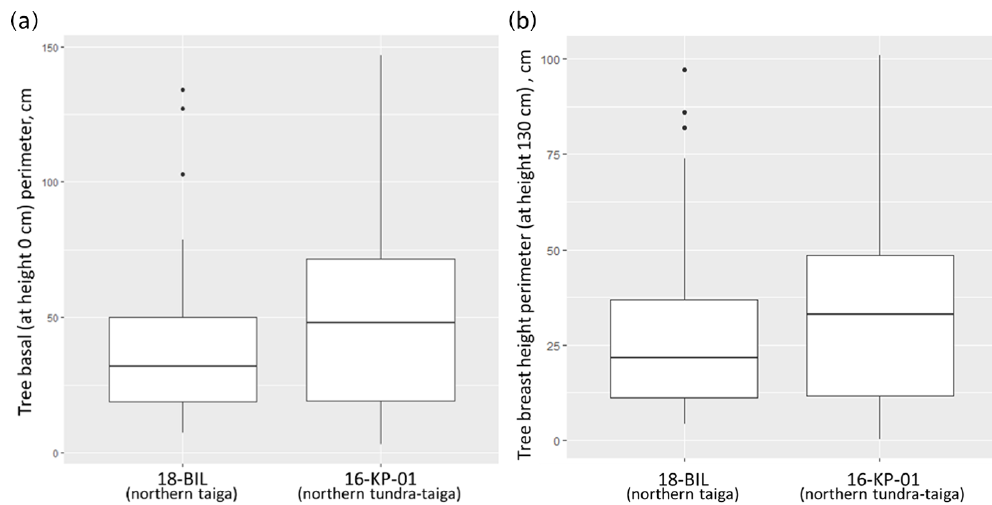
Figure A1. Distribution of basal (a) and breast height (b) diameter values of trees from two focus areas: northern taiga (18-BIL) and northern tundra–taiga (16-KP-01). We also made separate models for living and dead trees as there are obvious differences in the wood densities and no needle material for dead trees. Total AGB of a tree was calculated from partial needle and wood biomass